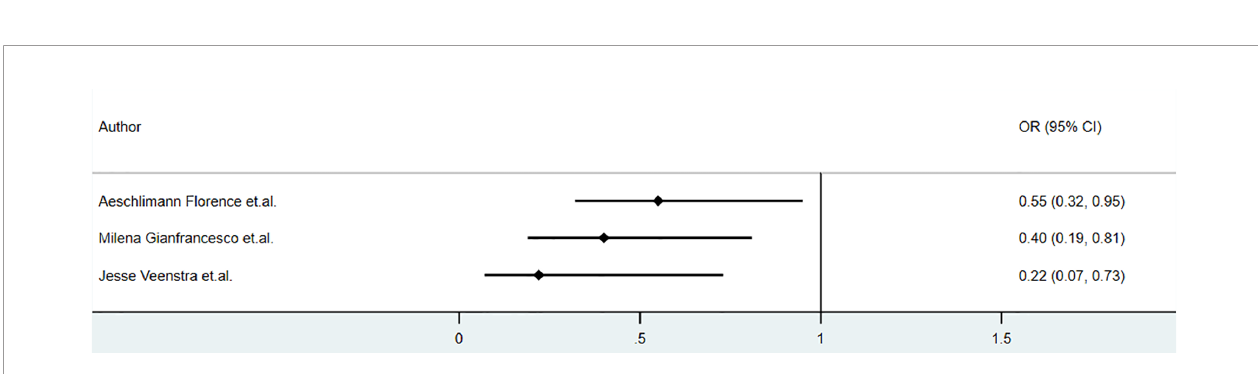
FIGURE 6 | The association of anti-TNF agents and hospitalization of COVID-19 among patients with immune-mediated in fl ammatory diseases (IMID)